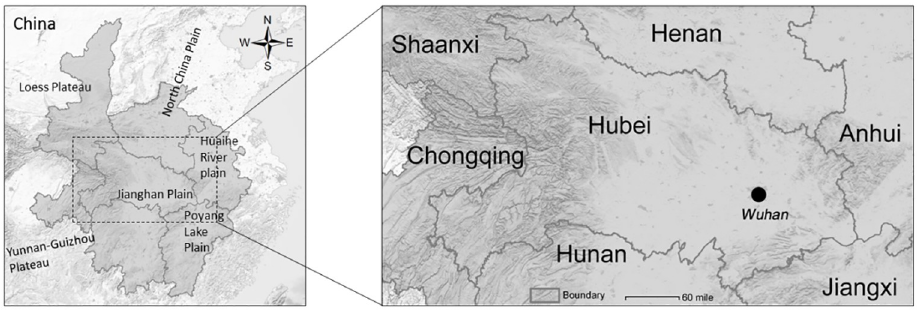
Fig 1. The location of Hubei province and its surrounding six provinces. (figure was drawn by author based on USGS basic information for illustrative purposes only, USGS National Map Viewer (public domain): http://viewer.